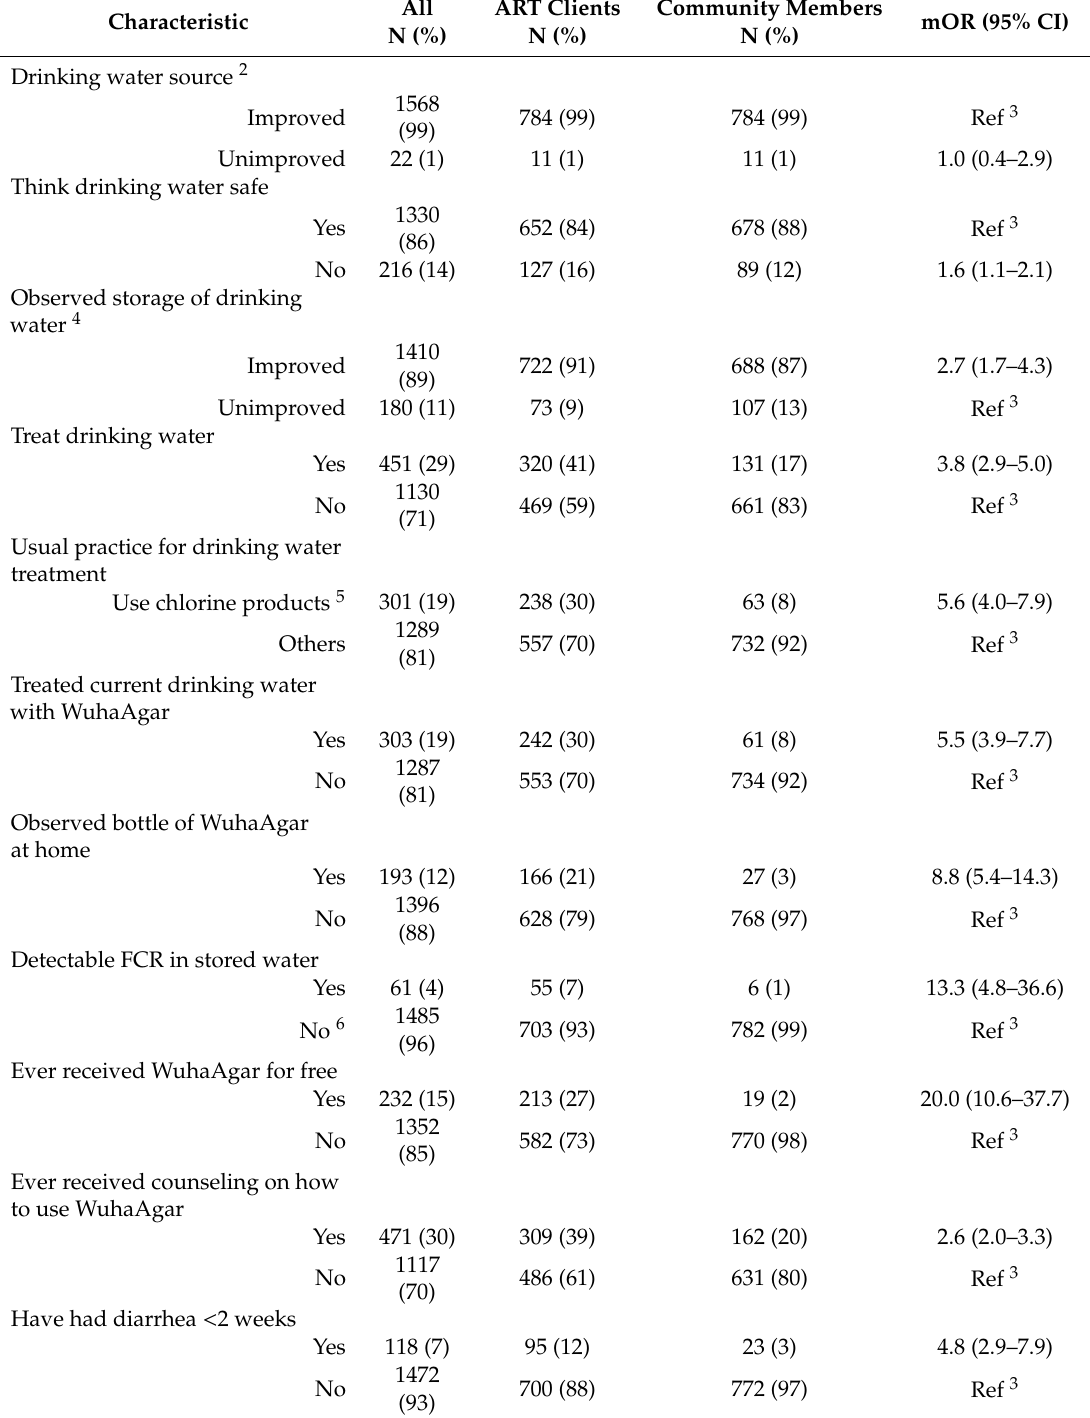
Table 2. Household drinking water source, storage, treatment, and diarrhea incidence, N 1 (%), of ART clients ( n = 795) and community members ( n = 795), and matched odds ratio (mOR) of being ART client, Ethiopia,